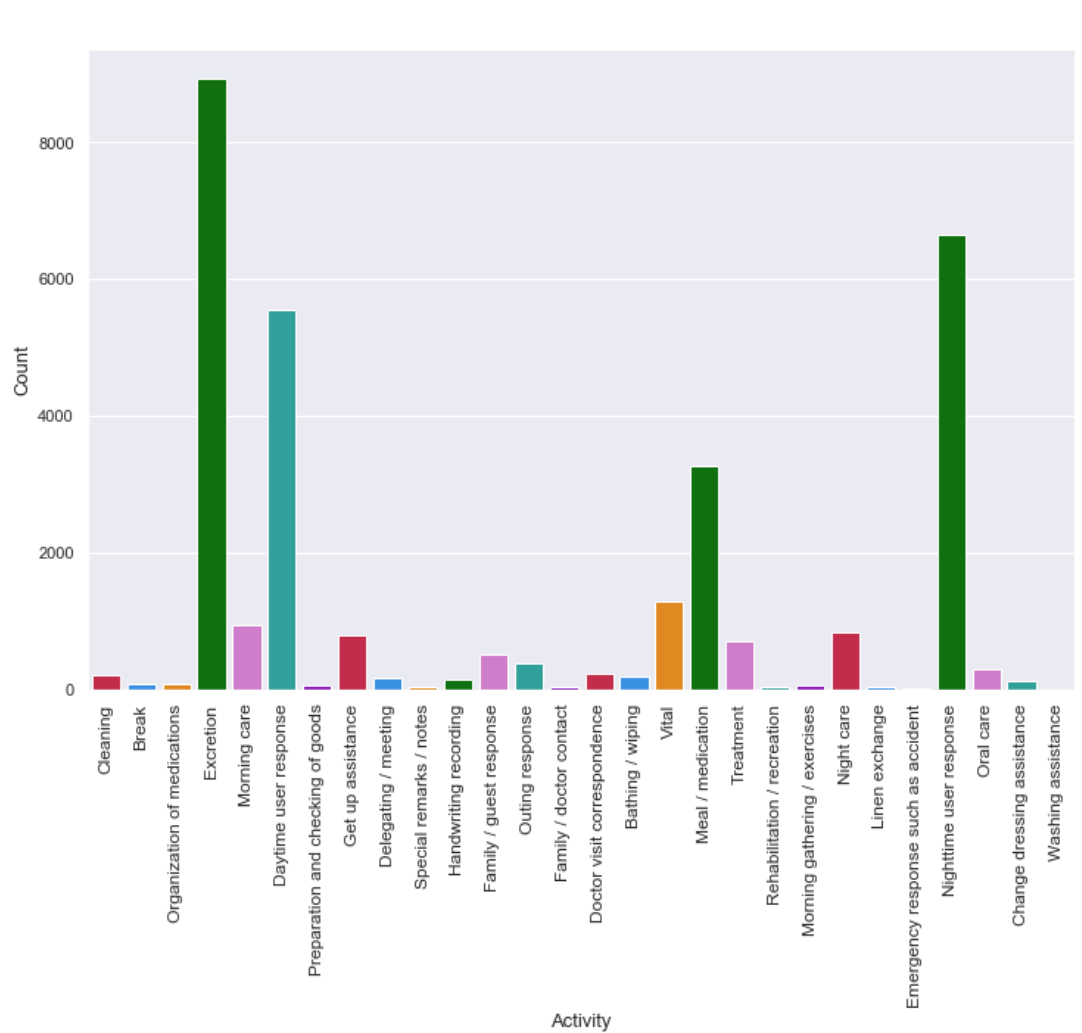
Figure 13. Nursing care dataset with 21 complex activity